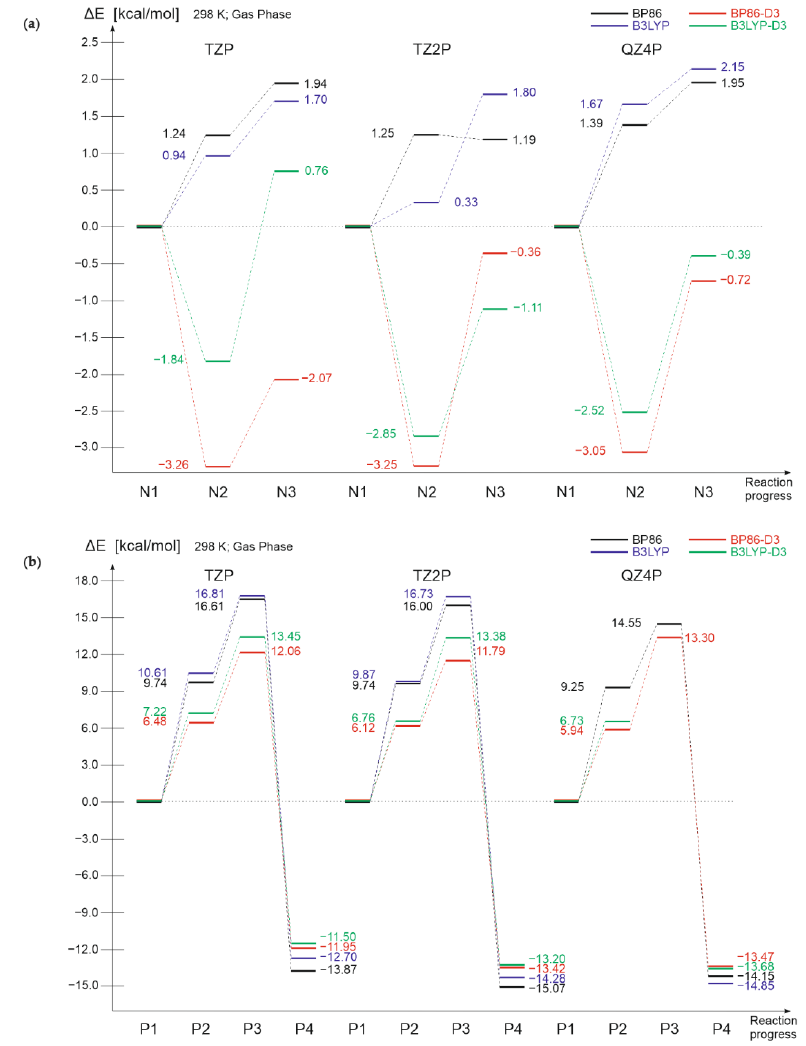
Figure 6. Relative electron energies of ( a ) nylon 6 and ( b ) PHB structures obtained using different computational details; labels of the structures correspond to given in Figures 2 − 5.